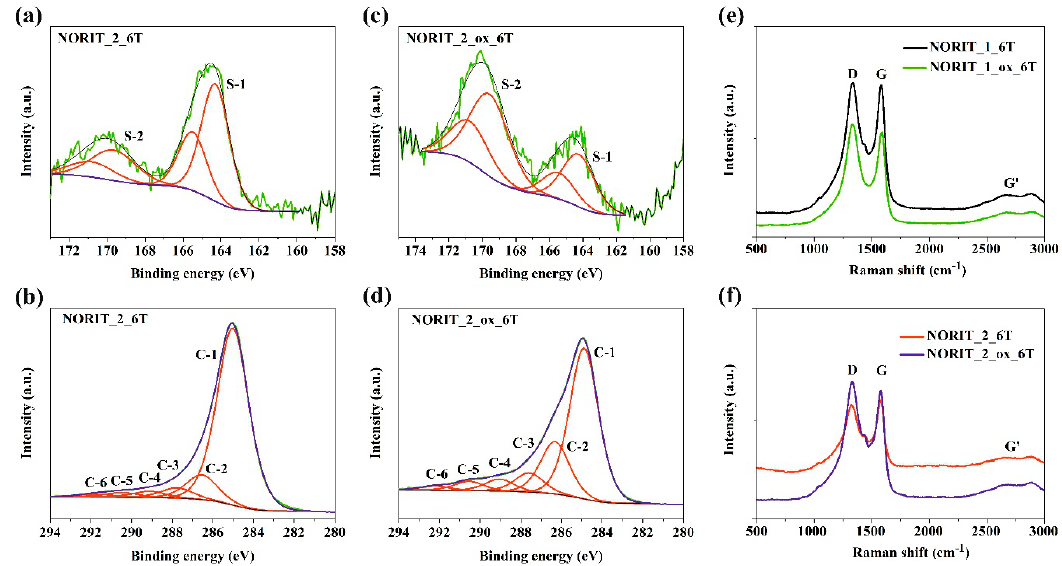
Figure 4. XPS spectra for: ( a ) S2p3 for NORIT_2_6T, ( b ) S2p3 for Norit_2_ox_6T, ( c ) C1s for Norit_2_6T, ( d ) C1s for Norit_2_ox_6T sample, ( e ) and ( f ) Raman spectra of hybrid materials modified with 6T- α -sexithiophene. Table 2. Results of the XPS spectra elaboration in C1s, O1, S2p3 region and total content of N and Si of the samples.